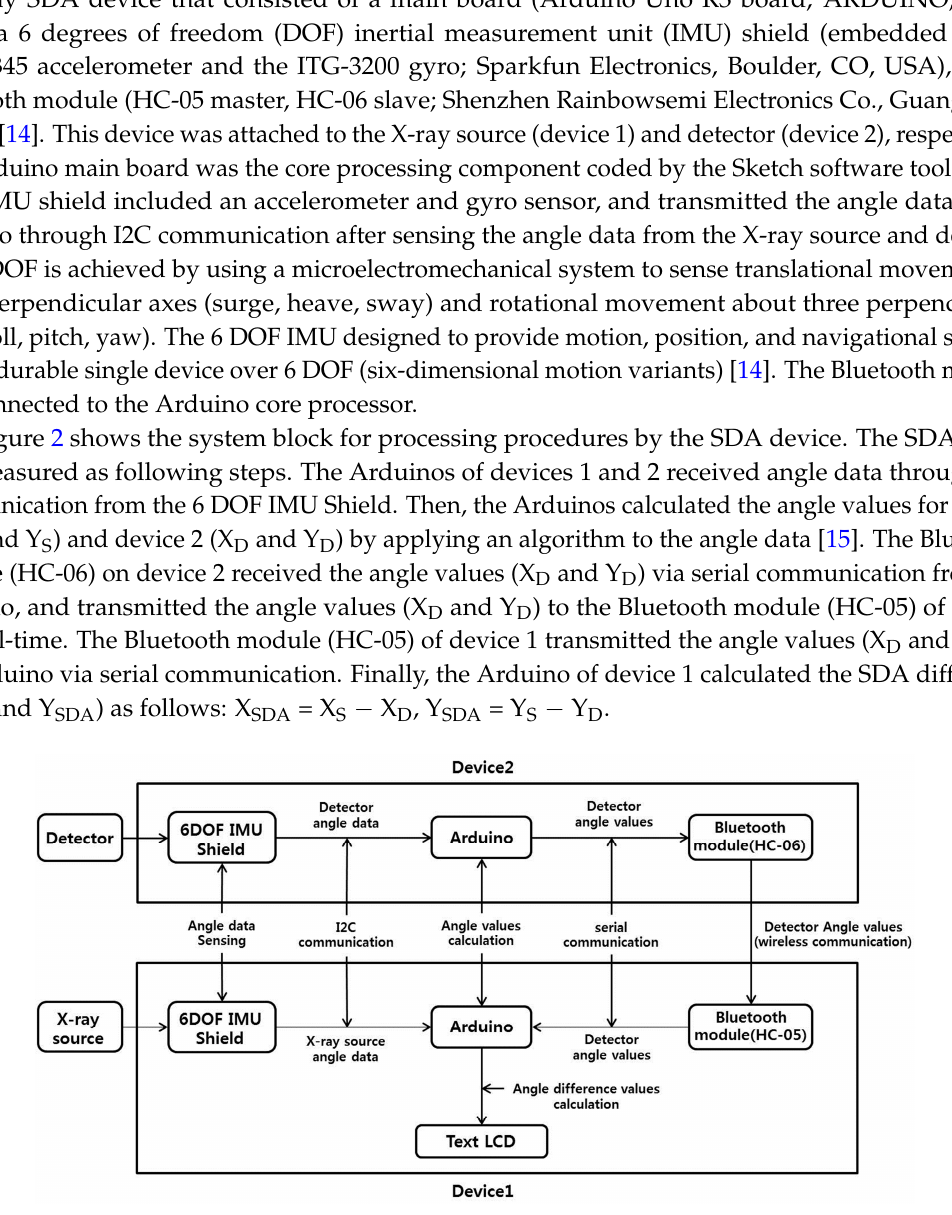
Figure 2. System block of the device for obtaining the X-ray source-detector angle (SDA).